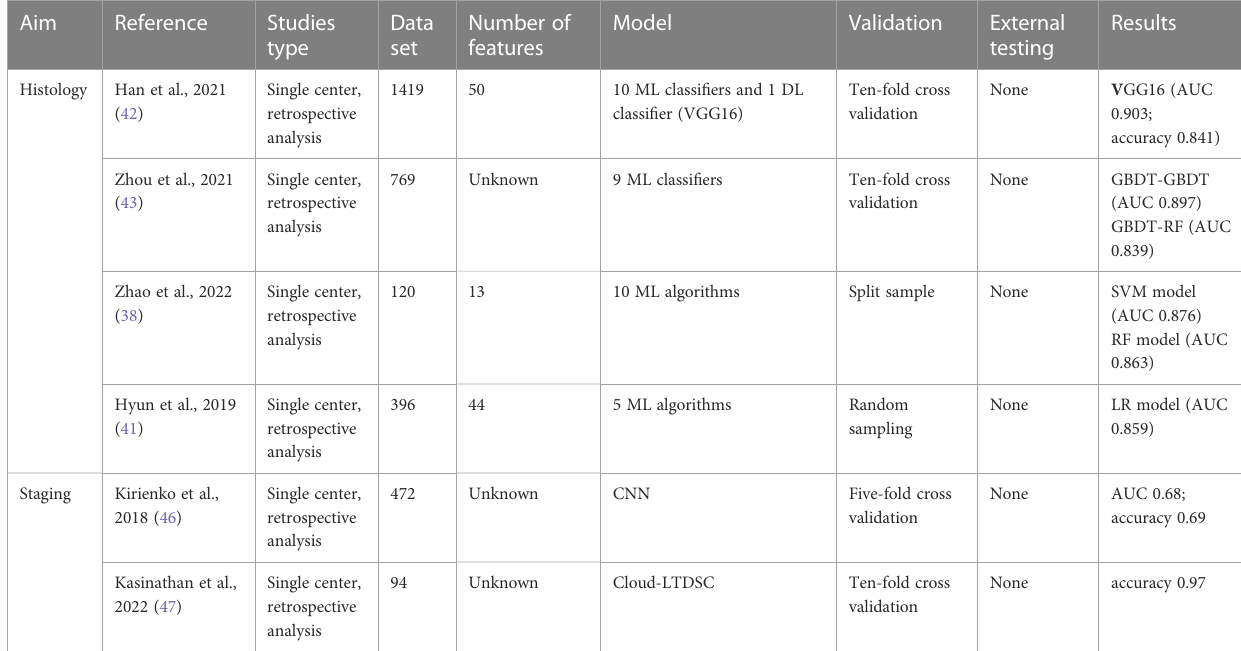
TABLE 2 Main fi ndings on histology and